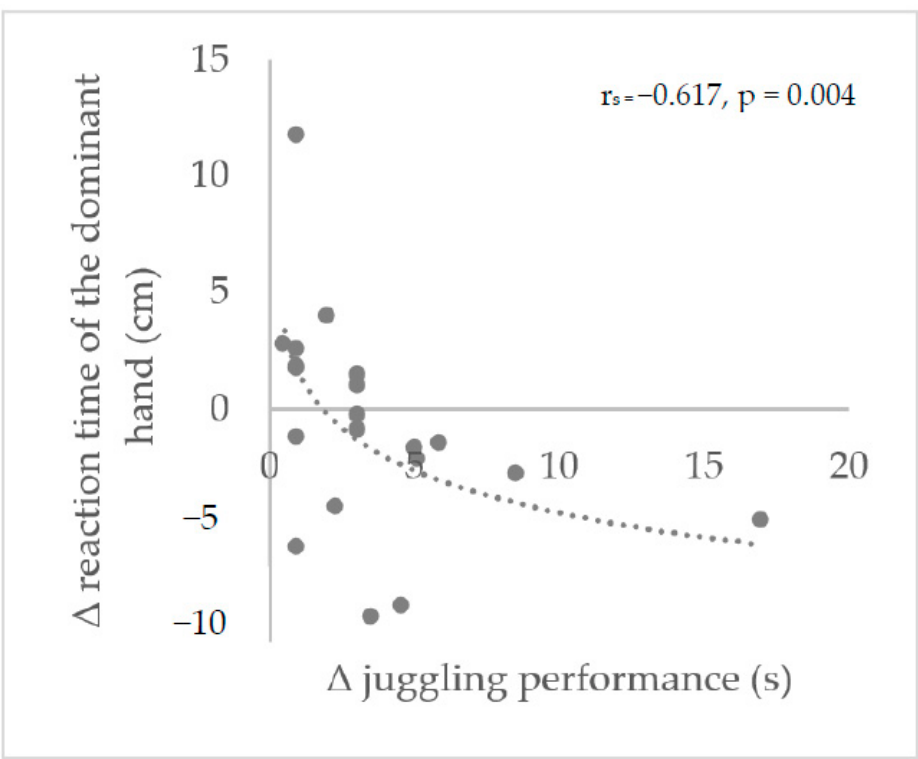
Figure 4. Spearman’s correlation of the changes over 12 weeks of the 3-ball-cascade absolute time and the changes in reaction time over 12 weeks of the absolute distance of the dominant hand at the Fall Stick Test. The negative relationship between ∆ the reaction time and ∆ the juggling performance represent a positive result: the greater the reduction of the reaction time, the greater the increase in juggling performance.